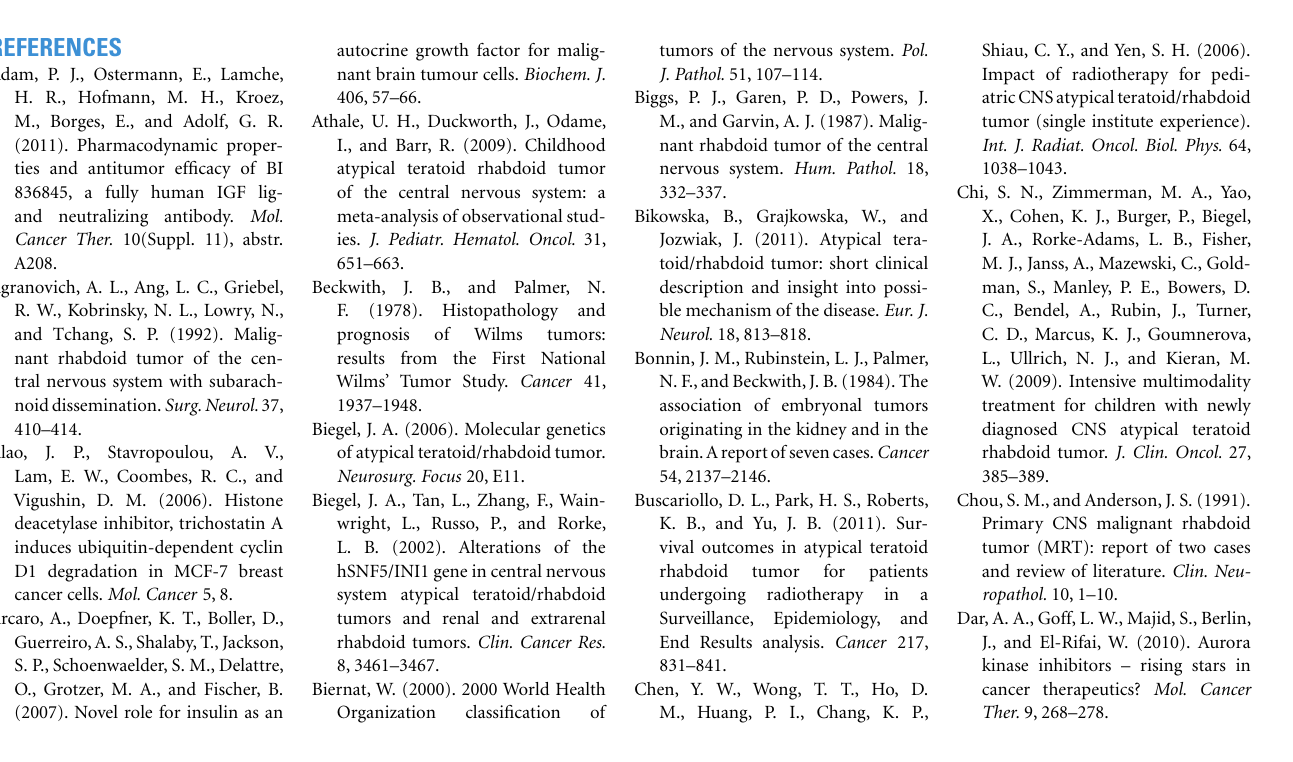
FIGURE 1 | Potential therapeutic targets inATRT. Studying the effects of the reintroduction of INI1 as well as the effects of its loss has led to the identification of multiple potential therapeutic targets. INI1 loss leads to increased cyclin D1 which propagates the cell through the G1-S checkpoint. HDAC inhibitors as well asVitamin A